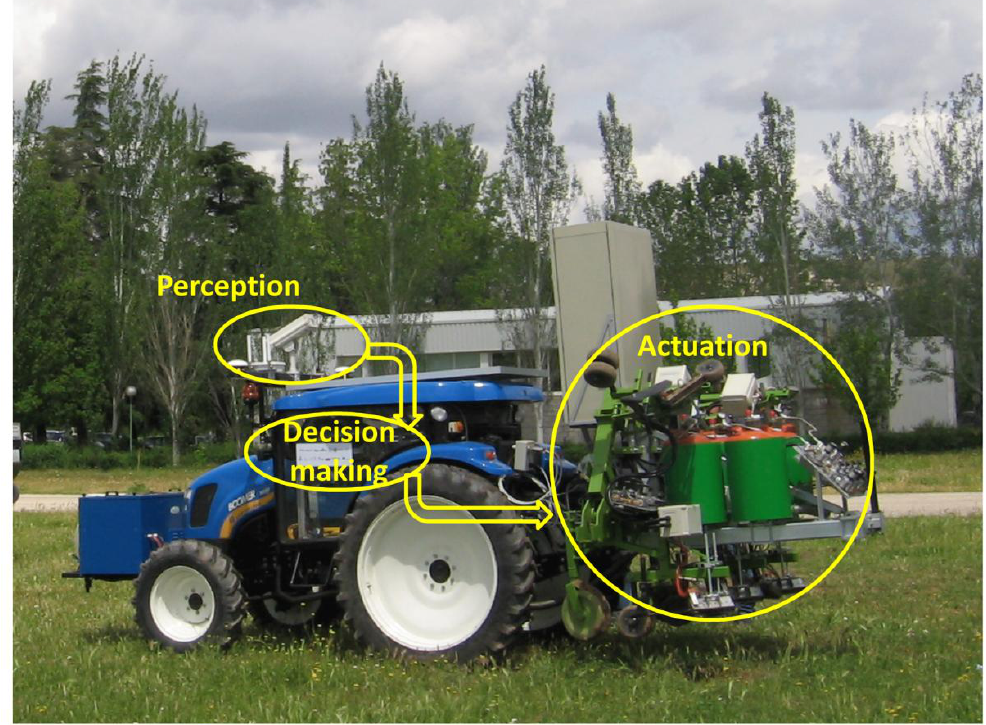
Figure 2. Perception, decision making, and actuation in an agricultural